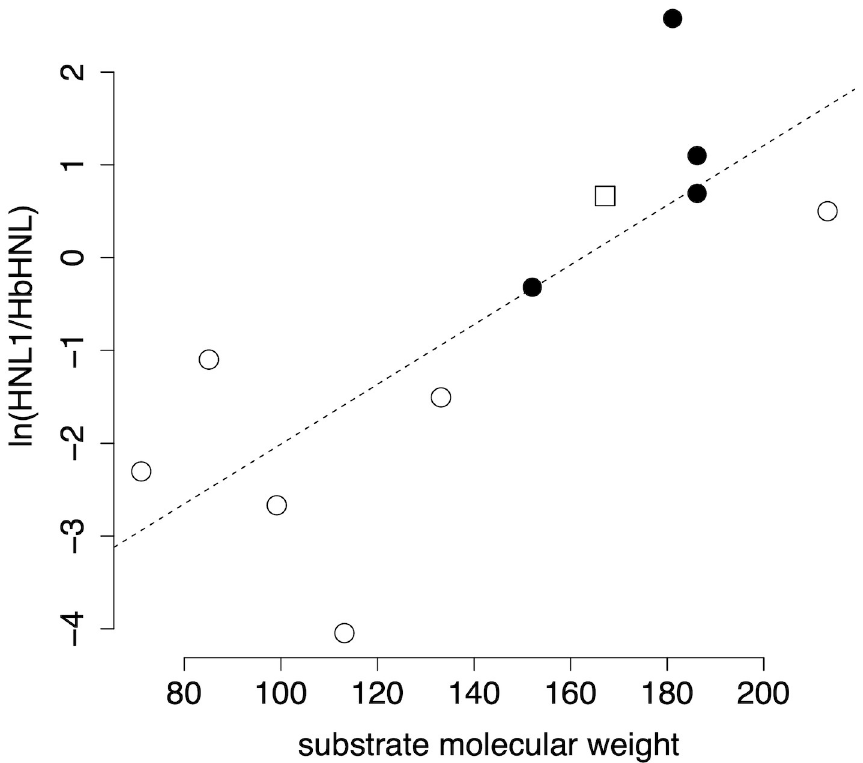
Fig 2. HNL1 favors larger substrates as compared to Hb HNL. The y-axis is the natural logarithm of the relative rate of the HNL1-catalyzed reaction versus the Hb HNL catalyzed reaction, while the x-axis is the molecular weight of the substrate, which approximates its size. The open symbols indicate lyase-type reactions: open circles are cleavage of cyanohydrins and the open square is the cleavage of 2-nitro-1-phenyl ethanol (reverse of a nitro-aldol addition). The filled black circles indicate hydrolysis of esters. The best linear fit (dashed line) is y = 0.032 ± 0.009 � x– 5 ± 1 and the r 2 = 0.61. Data for this figure are in S2